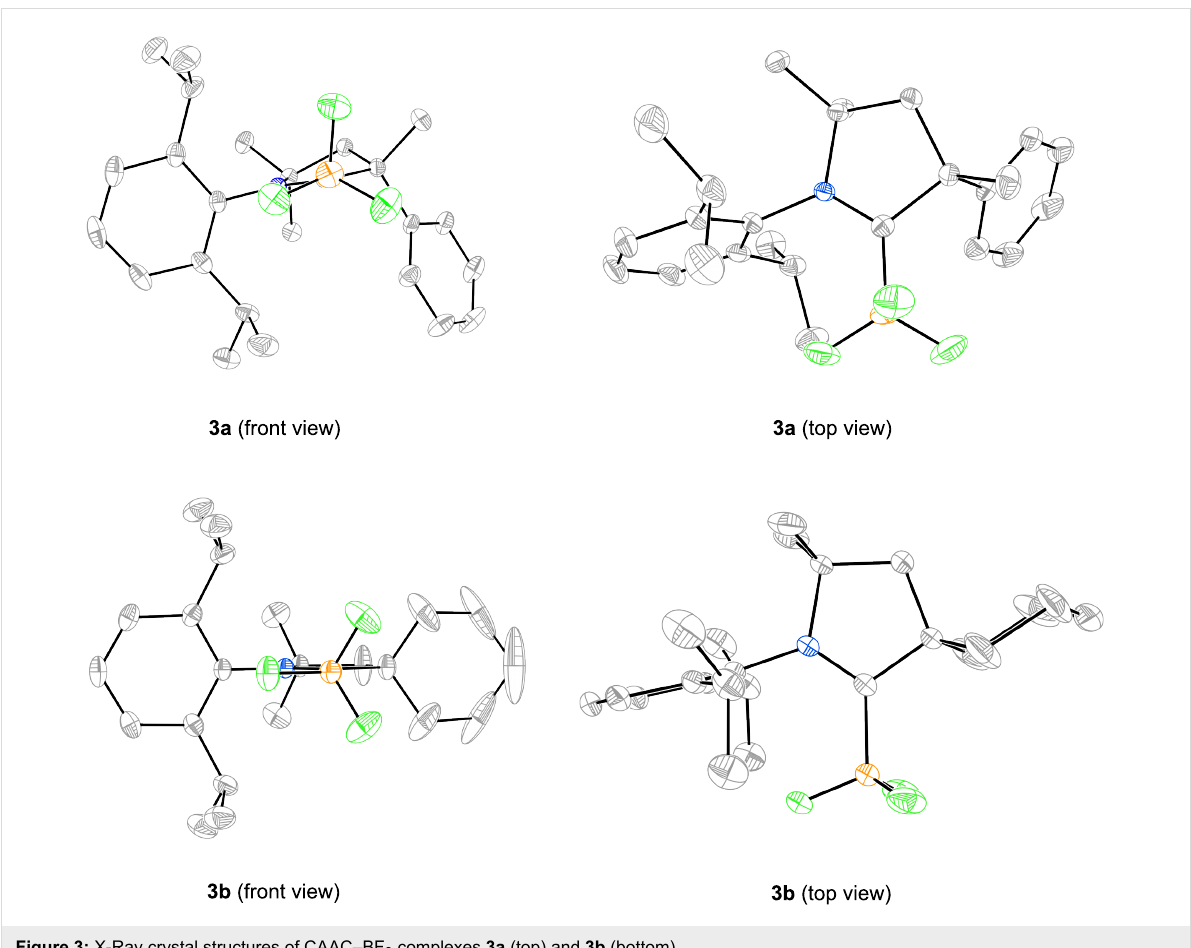
Figure 3: X-Ray crystal structures of CAAC–BF 3 complexes 3a (top) and 3b (bottom).